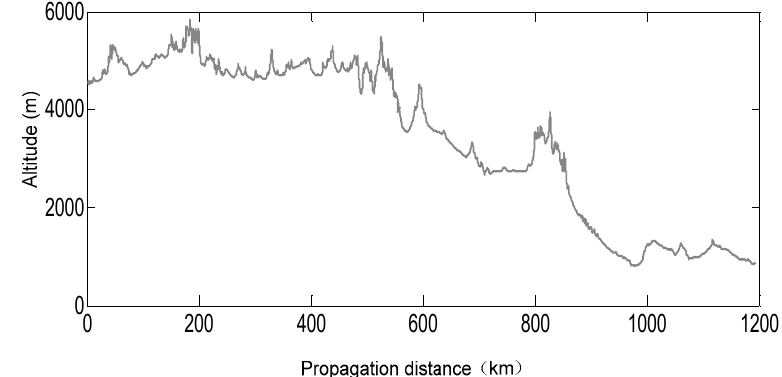
Figure 17. Landform profile of the Naqu region due north.